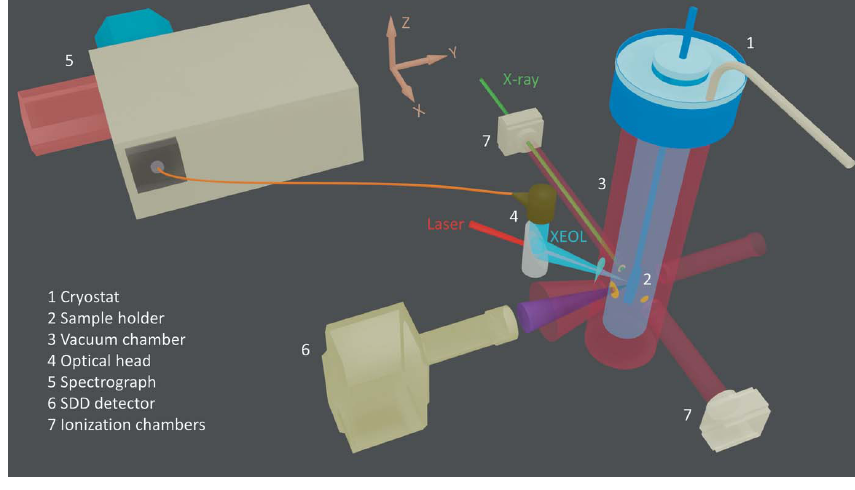
Figure 1 Schematic illustration of the XEOL setup at beamline P65 of PETRA III. The propagation of the X-ray beam is along the x -axis